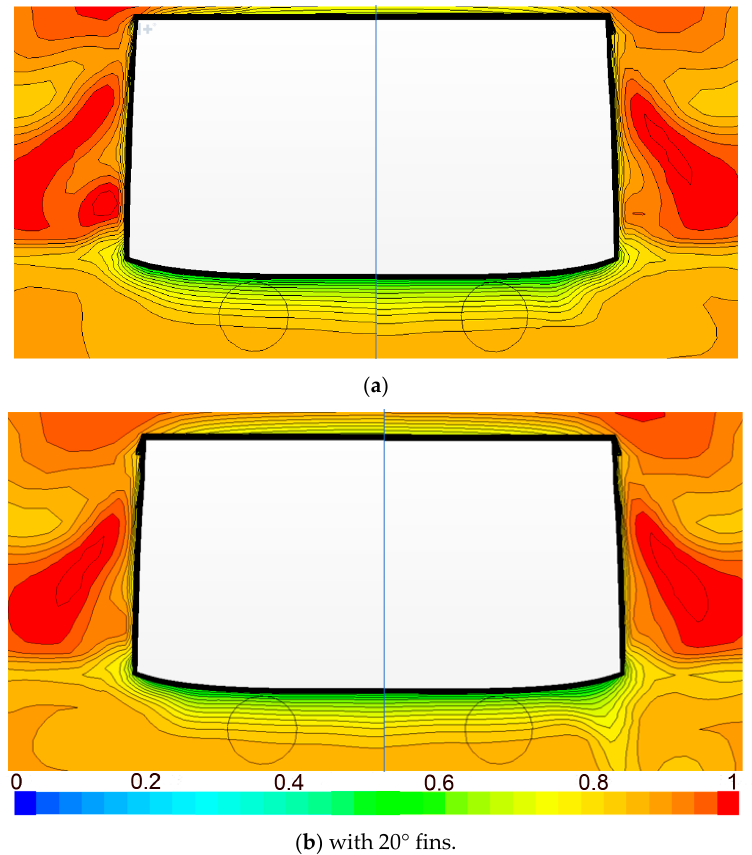
Table 7. Error analysis in model scale (unit: %).